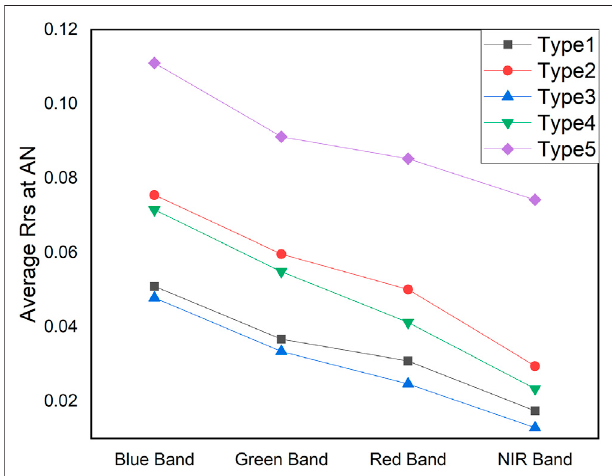
Frontiers in Environmental Science |